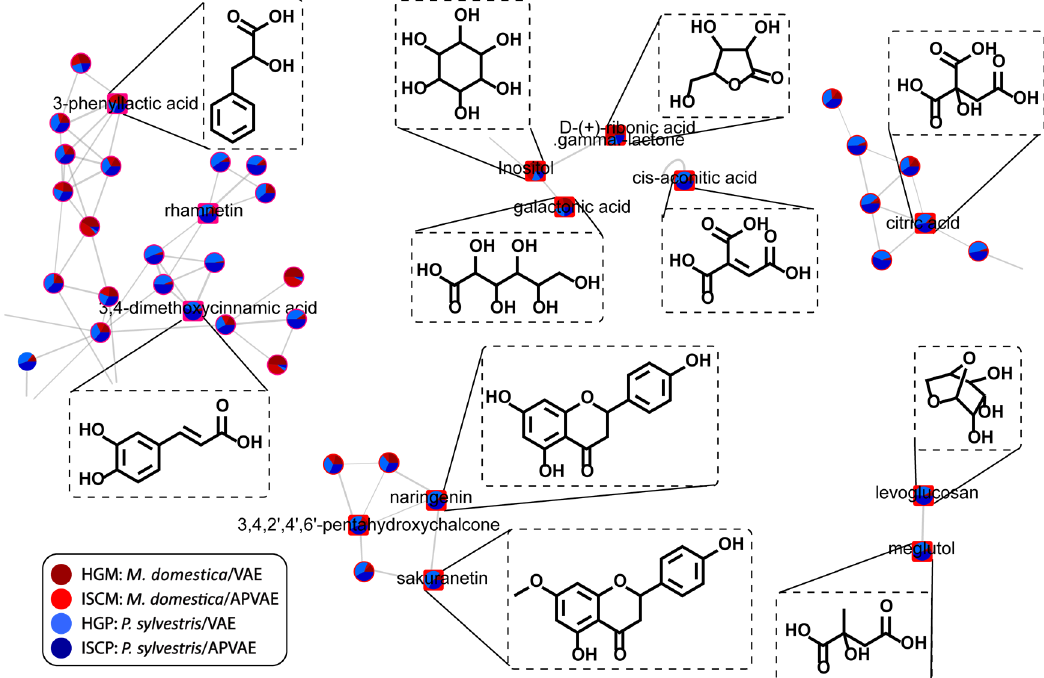
Figure 7. Nodes from the molecular network highlighting the compounds with high loading value in PLS-DA analysis and their distribution across different sample groups of fermented aqueous extracts of V. album.